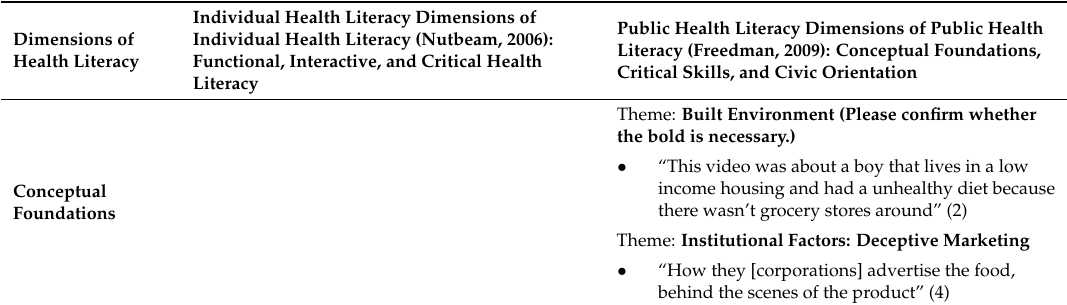
Table 3. Representative coded rubric of responses related to dimensions of health literacy obtained in the post-film survey and focus group responses.